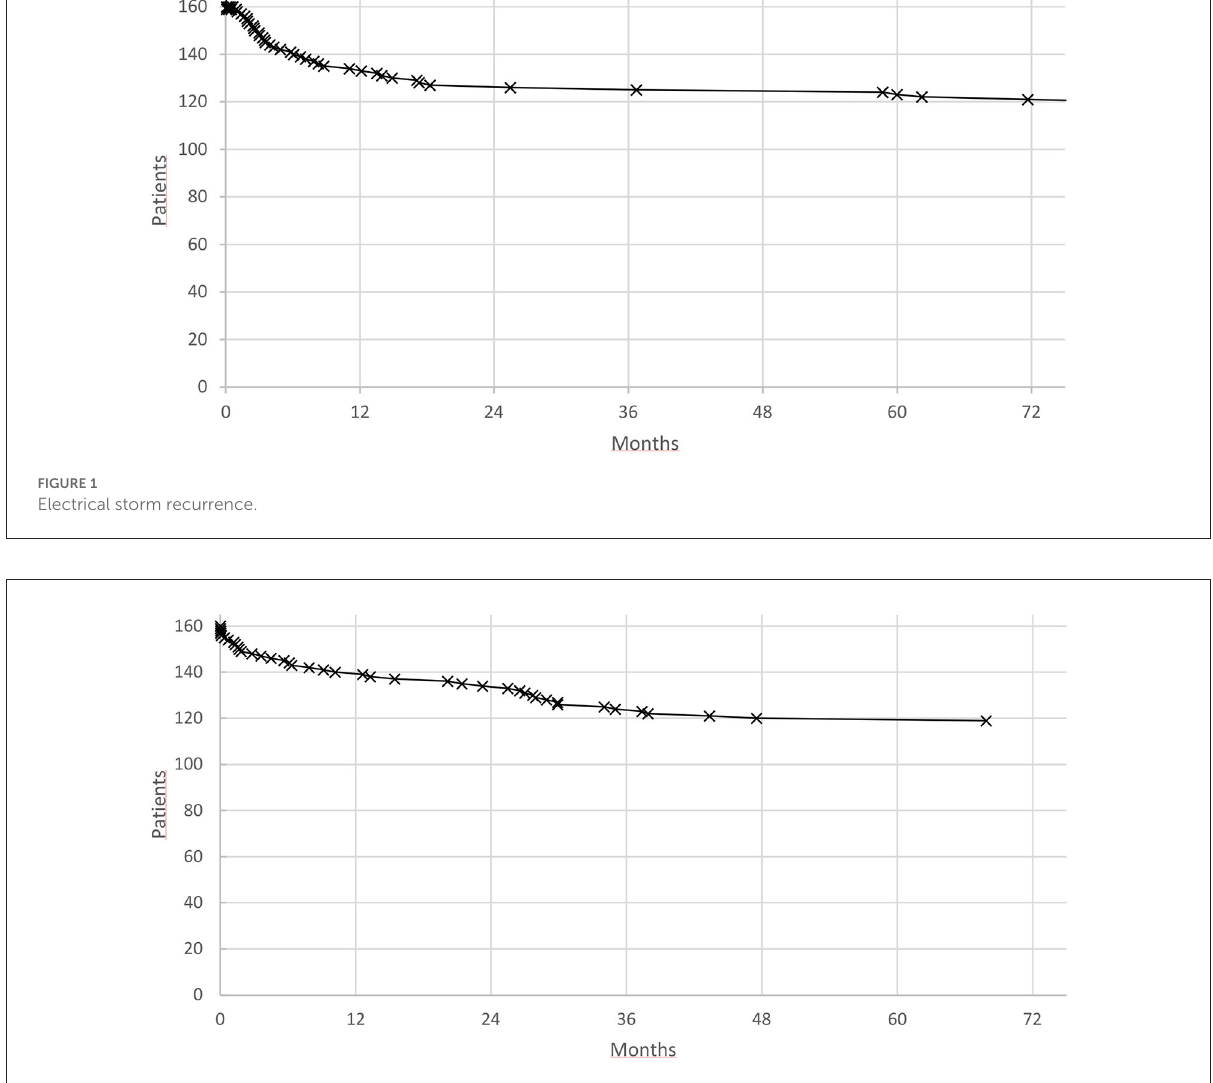
FIGURE2 Mortality after substrate modification for electrical